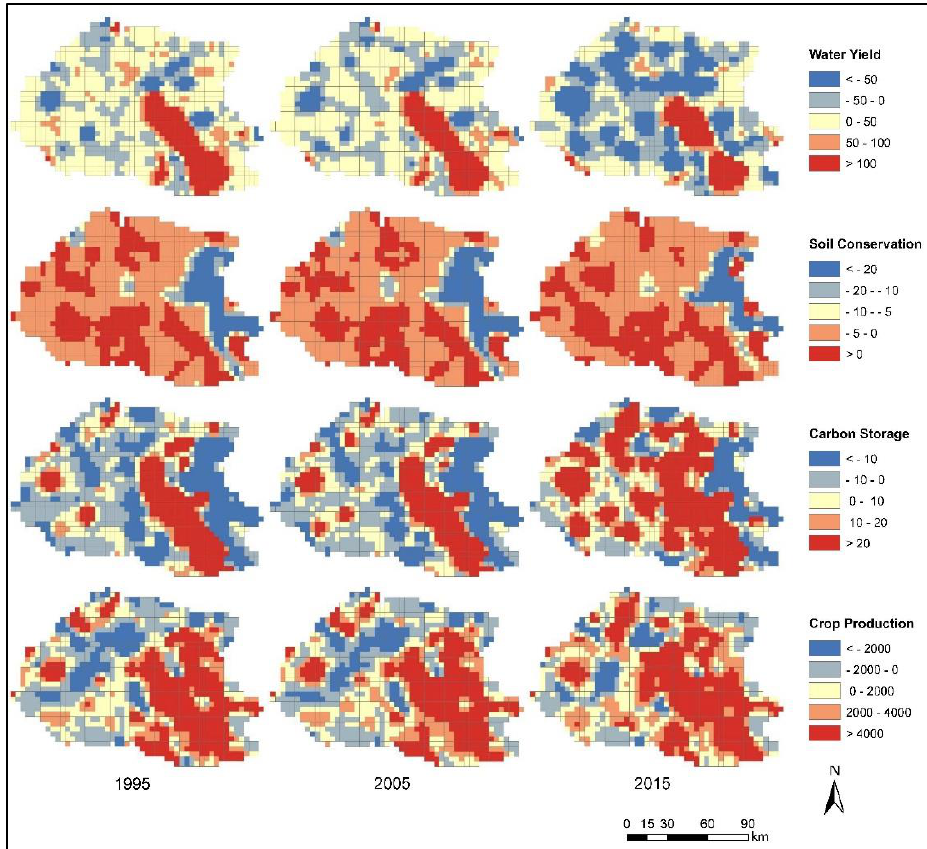
Figure 6. Spatial distributions of correlation coe ffi cients between patch density (PD) and ecosystem services.